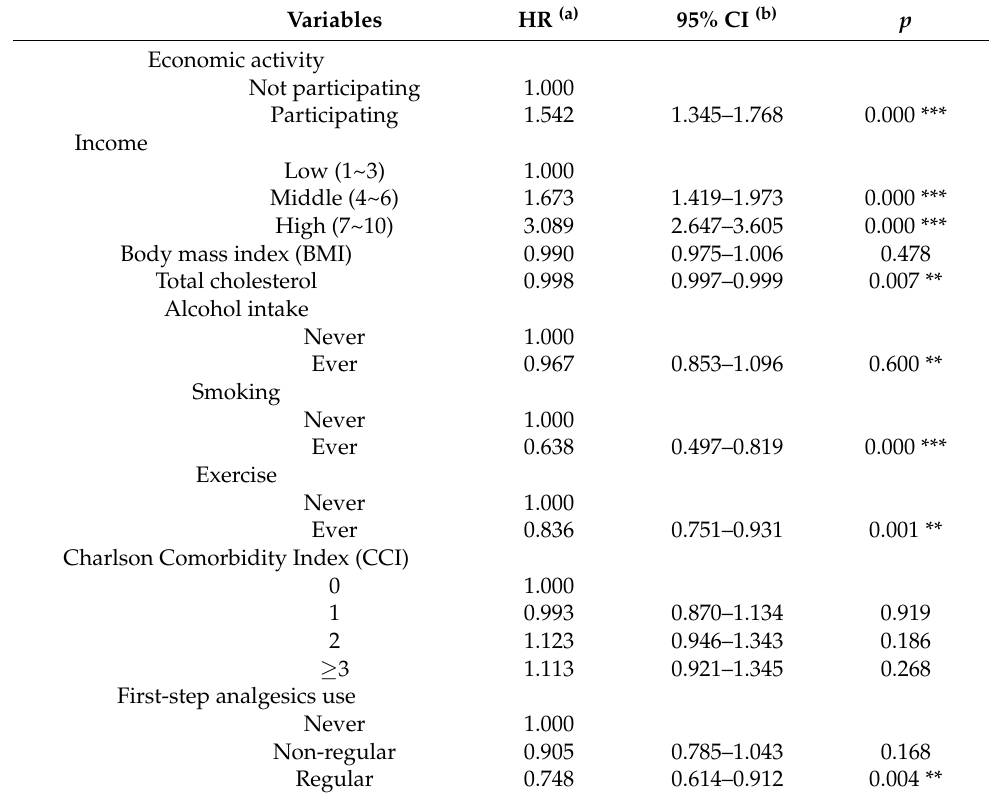
Table 2. Hazard ratios (HRs) associated with cancer development in a cohort of 6735 patients.